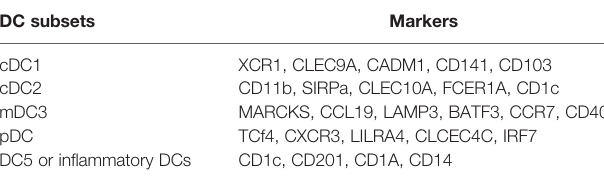
TABLE 1 | Tumour in fi ltrating DC subsets detected in various human solid tumours – Liver, Ovarian, Lung, Breast and Colorectal (69, 70). DC